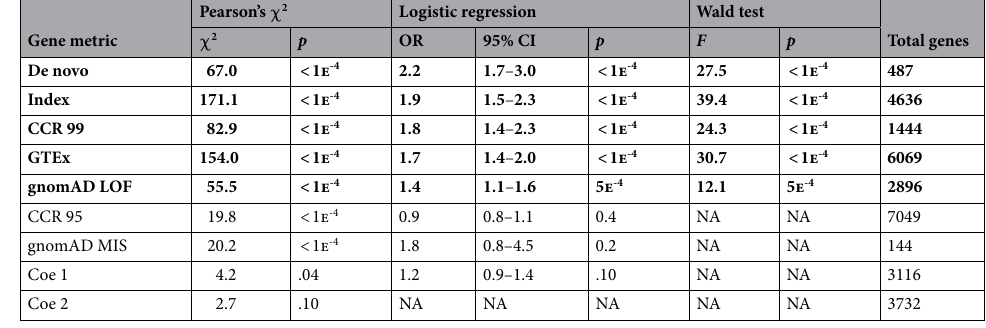
Table 1. NeuroSCORE gene metric association of genes with CNS-related clinical features. Bold text indicates variables used in the final model; OR: odds ratio; 95% CI 95% confidence interval; CCR 95 or 99: genes with ≥ 1 critically constrained coding region at the 95th or 99th percentiles; GTEx: gene-tissue expression database; gnomAD LOF and MIS: gnomAD genes with upper bound of loss-of-function or missense observed/ expected metric < 0.35; NA: not applicable.